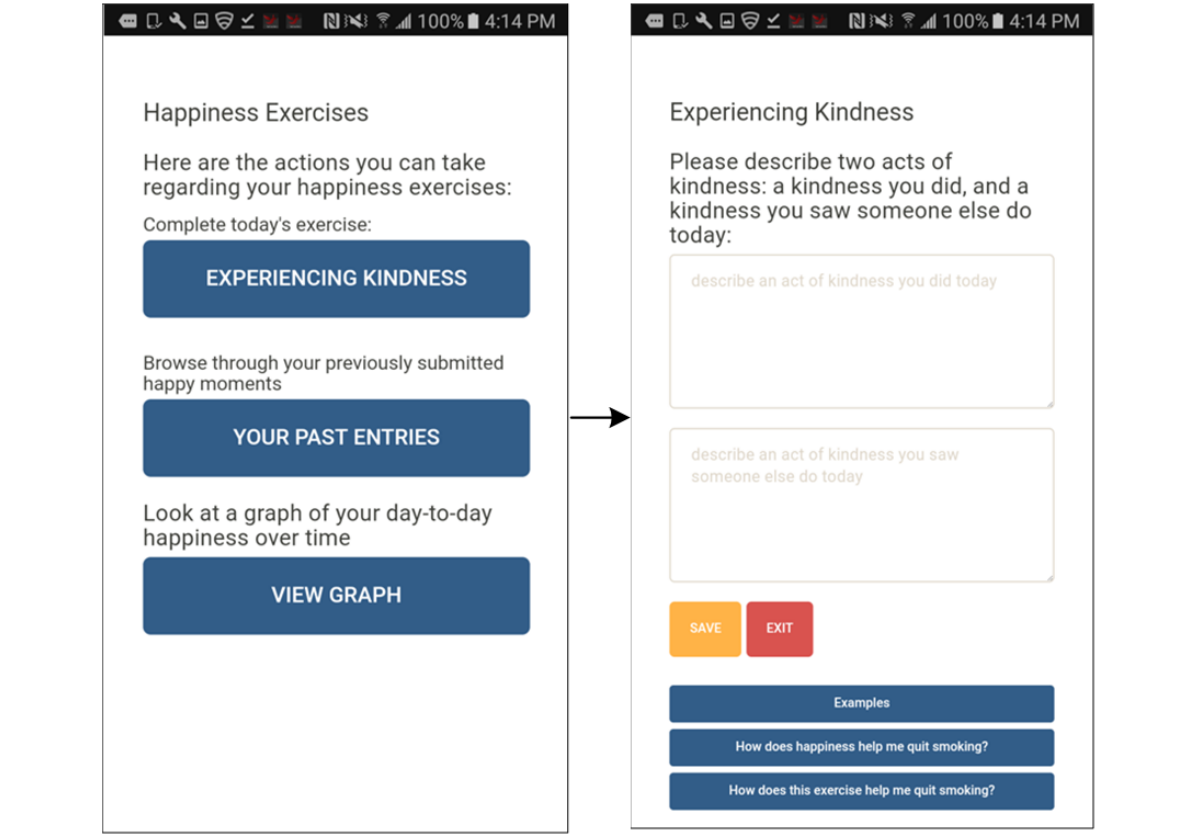
Figure 4. Screenshots of completing the daily happiness exercises in SiS1. SiS: Smiling Instead of Smoking.